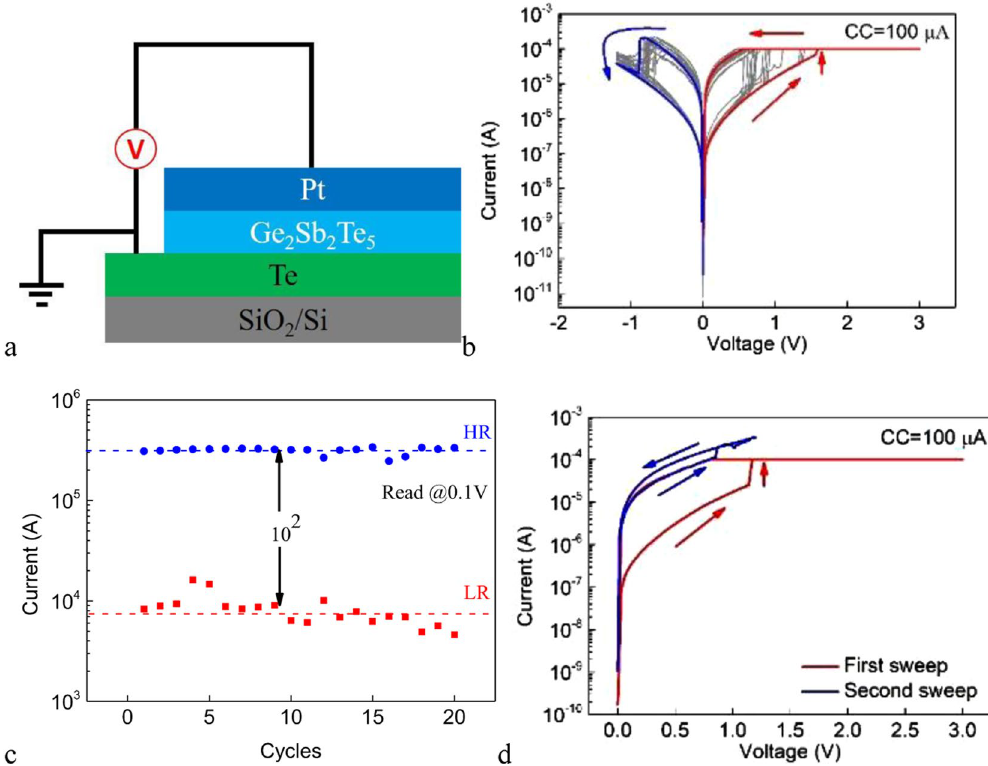
Figure 3. ( a ) The schematic structure of the Pt/Ge 2 Sb 2 Te 5 /Te cell. ( b ) The DC I-V curves of 20 consecutive sweep cycles for the Pt/Ge 2 Sb 2 Te 5 /Te cell under the SET CC of 100 μ A. ( c ) The LR and HR of the Pt/Ge 2 Sb 2 Te 5 /Te cell for 20 consecutive sweep cycles. The voltage of read pulse is 100 mV. ( d ) The DC I-V curves of two consecutive voltage sweeps only in the SET direction. The SET CC is 100 μ A.